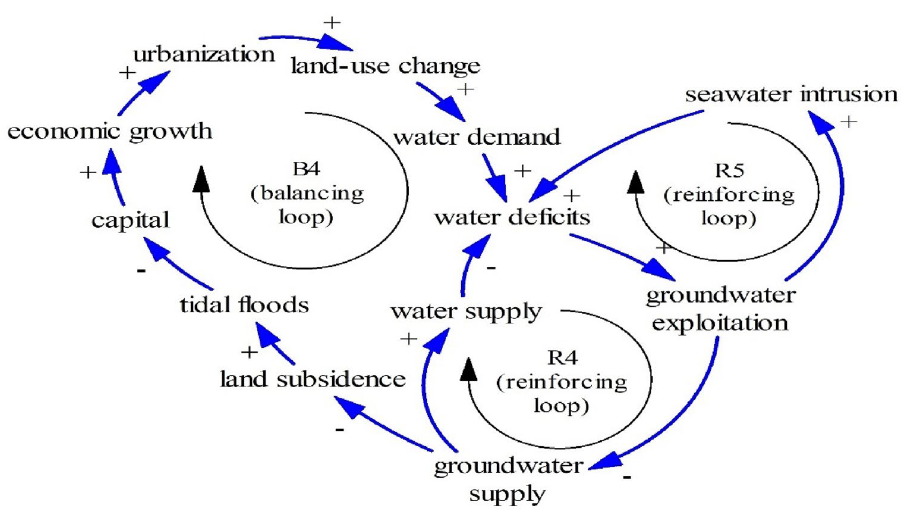
Figure 11. The Limits to Growth #4.